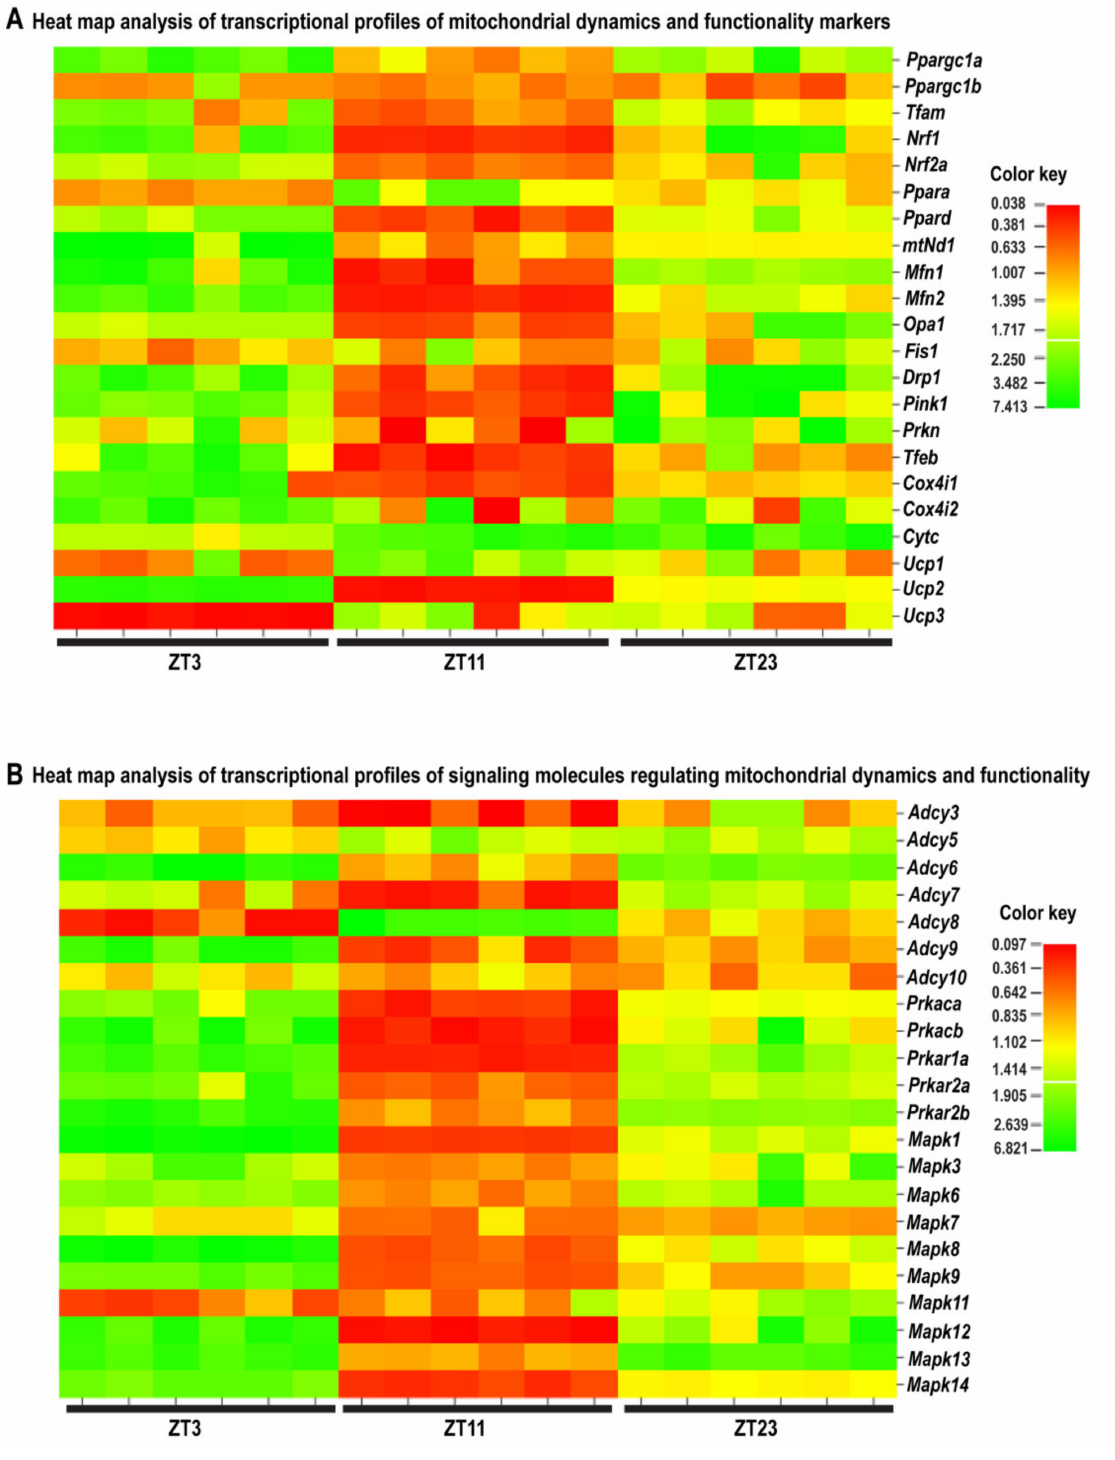
Figure 10. Heat map analysis of the transcriptional profile of mitochondrial dynamics and functional- ity markers ( A ) as well as signaling molecules regulating mitochondrial dynamics and functionality ( B ) in spermatozoa obtained from adult rats repeatedly stressed at different time points (ZT3, ZT11, and ZT23) during the day. Analysis showing different patterns of transcription at different time points in spermatozoa after repeated immobilization stress. Heat map analysis shows a relative fold of change in gene expression for the aforementioned markers at different time points (ZT3, ZT11, and ZT23), which are presented in colors from red to green, indicating low to high